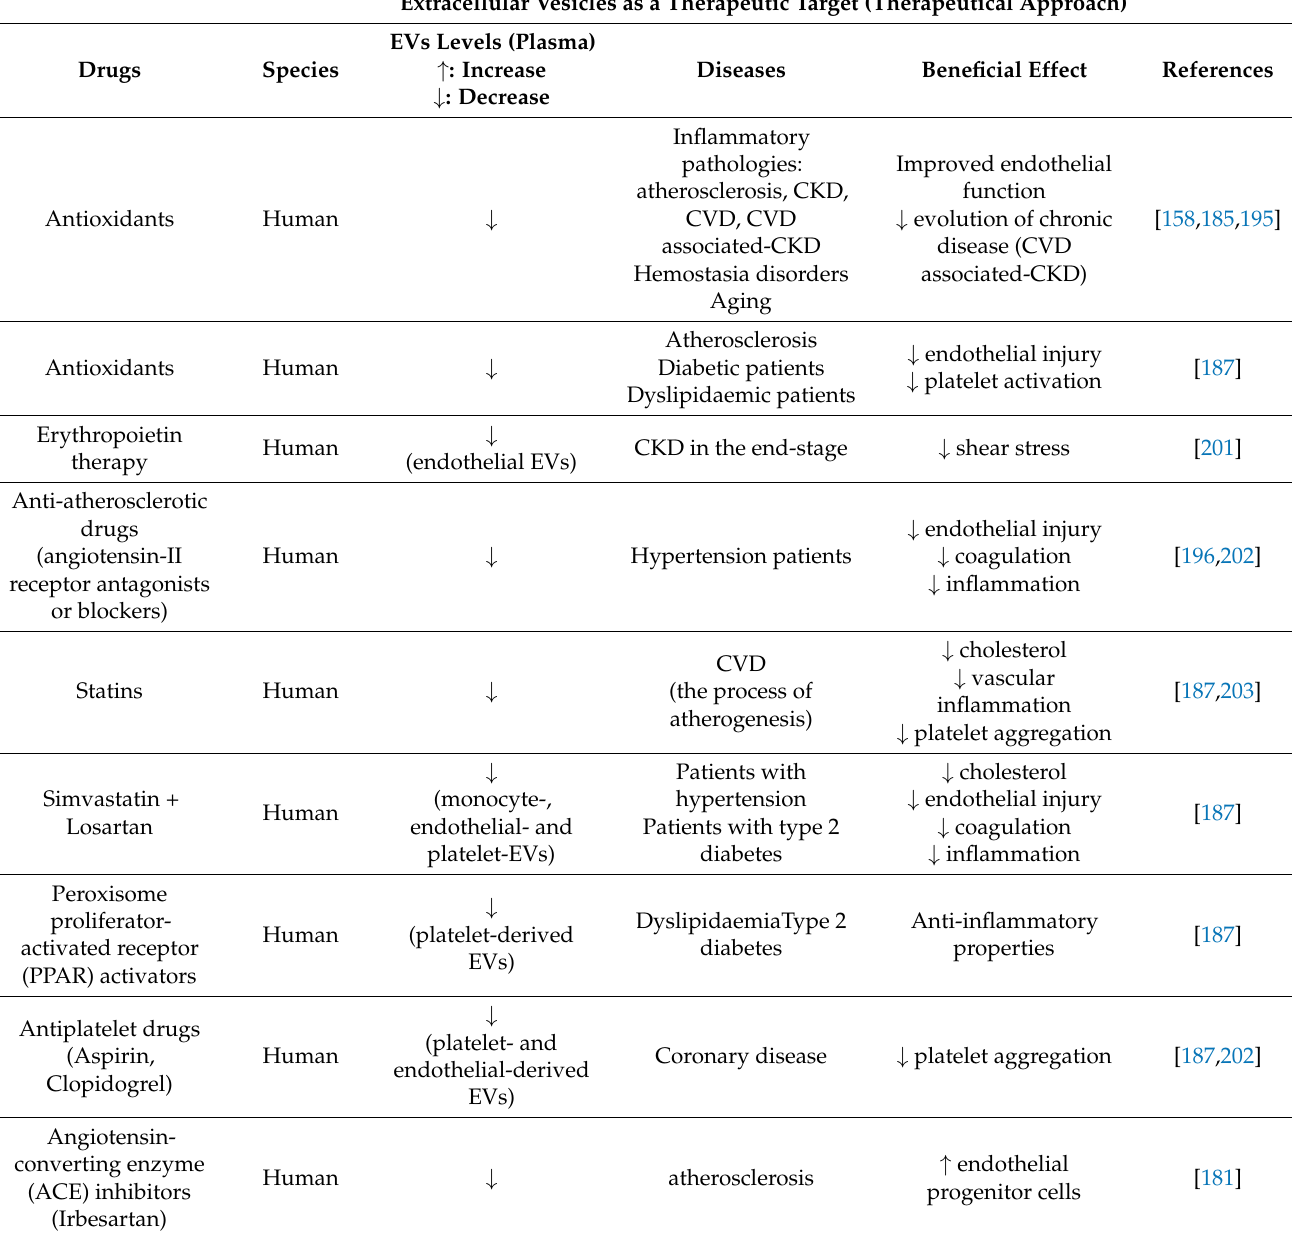
Table 3. EVs as target (pharmacological modulation of plasma